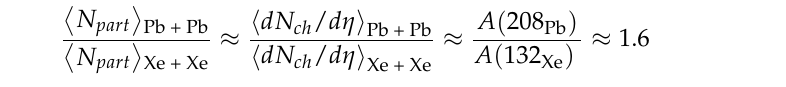
(cid:10) (cid:11) N part , (cid:104) dN ch / d η (cid:105) , and (cid:104) β T (cid:105) estimated in the present √ s nn = 5.02 TeV and compared to those extracted in a recent √ s nn = 5.44 TeV. The ratios of the corresponding quantities for